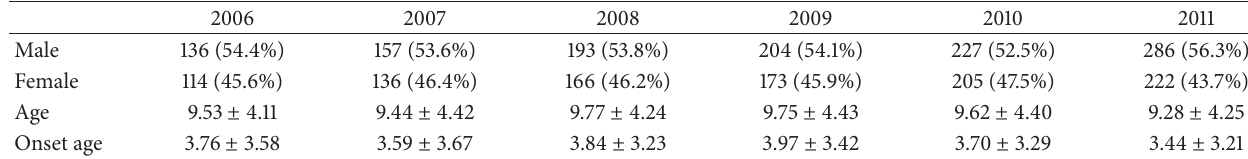
Table 1: Age and sex distribution ( 𝑥 ± 𝑠 ).